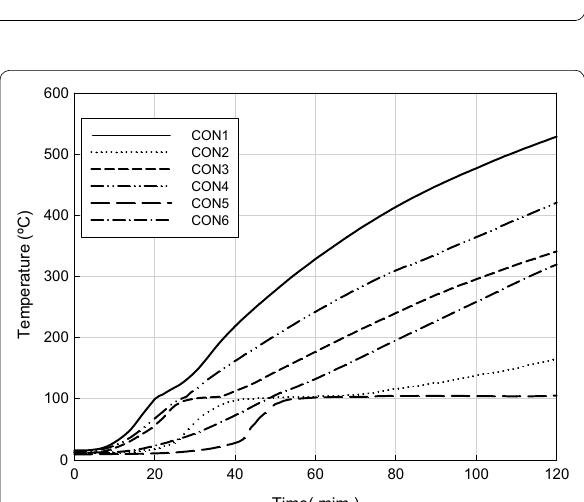
Fig. 8 Reduction rate of material strength with temperature.